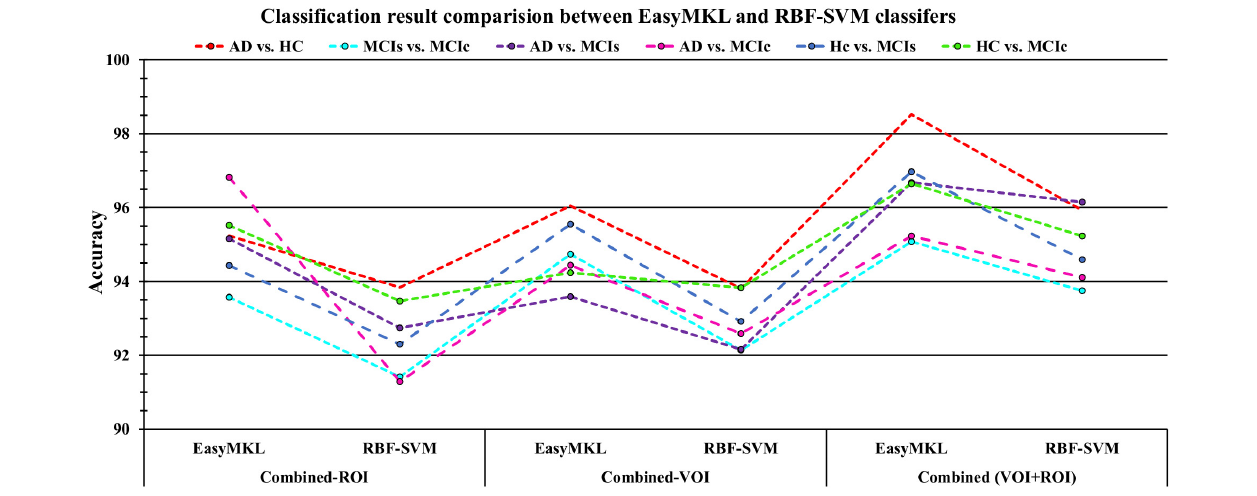
FIGURE 15 | Comparison of EasyMKL classifier results with RBF-SVM classifier results based on obtained accuracy score. In the above figure, we can see that the combined-ROI, combined-VOI, and combined-(VOI + ROI) result obtained by EasyMKL classifier outperformed the results [combined-ROI, combined-VOI, and combined-(VOI + ROI)] obtained by the RBF-SVM classifier for all six classification